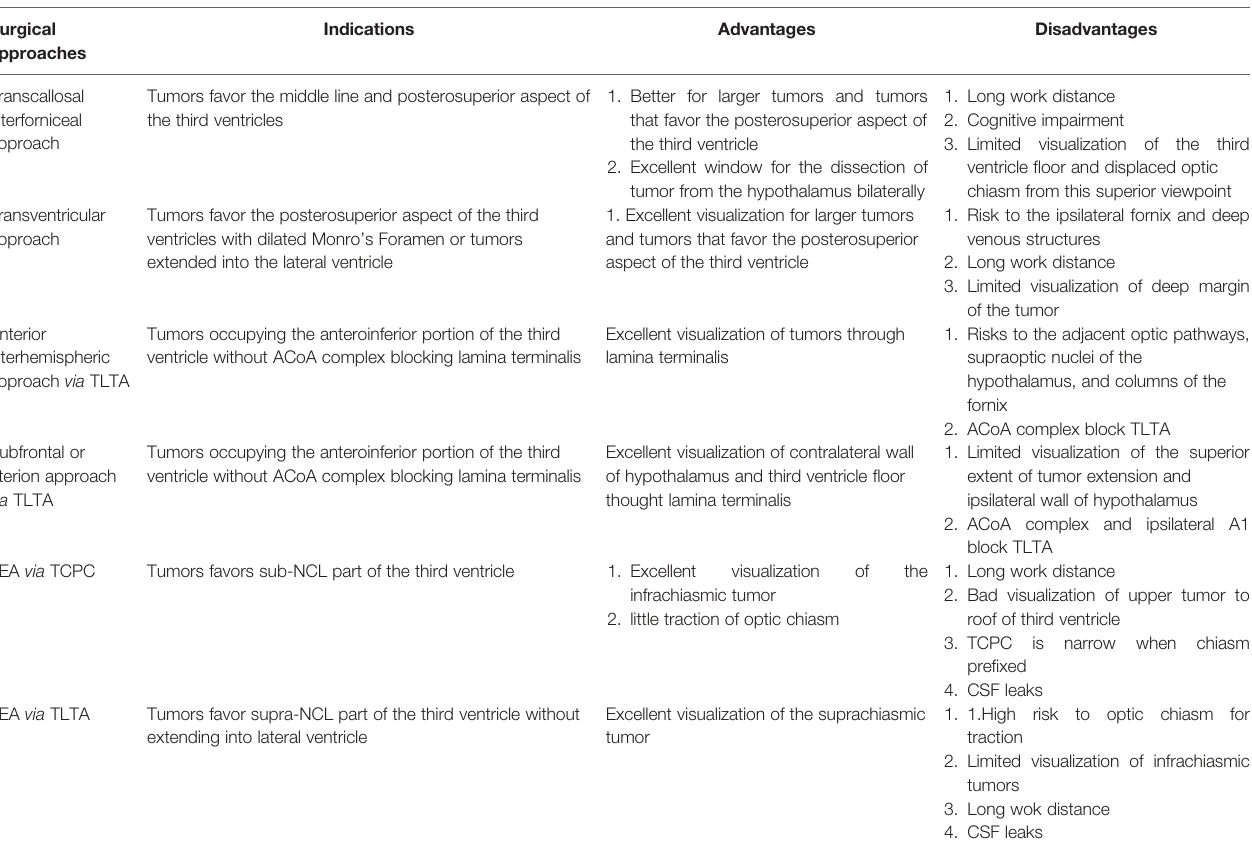
TABLE 4 | Indications and pros and cons of different surgical approaches to the tumors extended to third